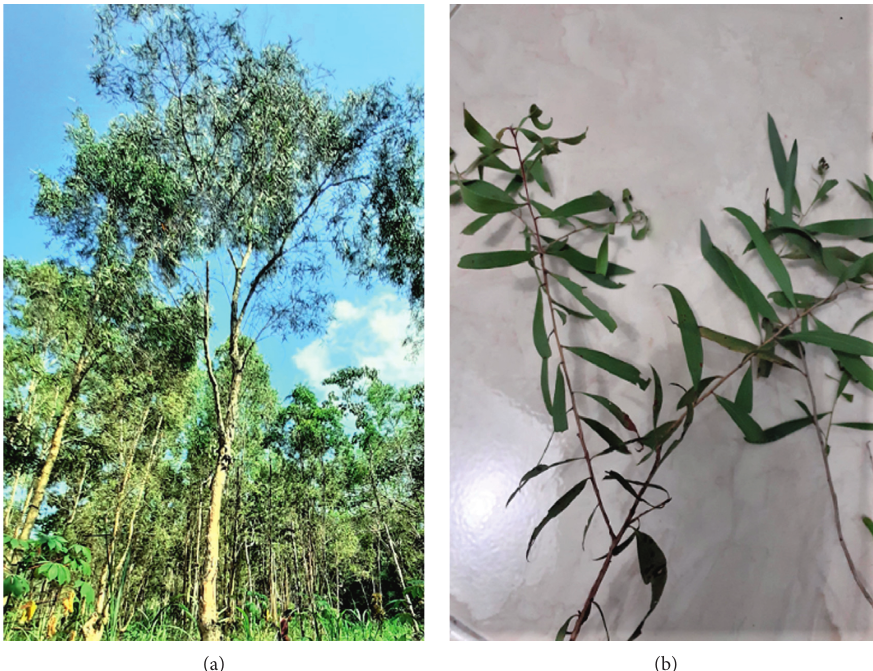
Figure 2: The habitus of (a) tree of cajuput and (b) its leaves. The photos were taken in Sendang Mole, Playen, Gunung Kidul, Daerah Istimewa